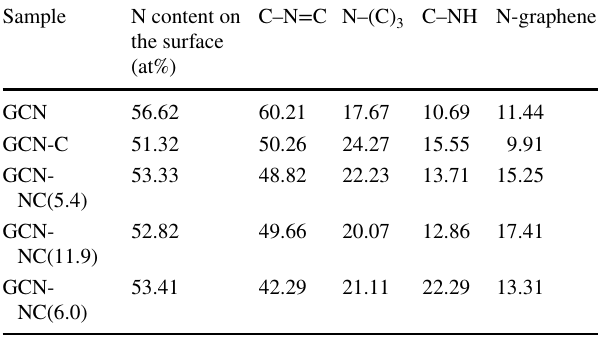
Table 2 Total content and relative amount of different nitrogen groups on the surface of the catalysts Sample N content on the surface